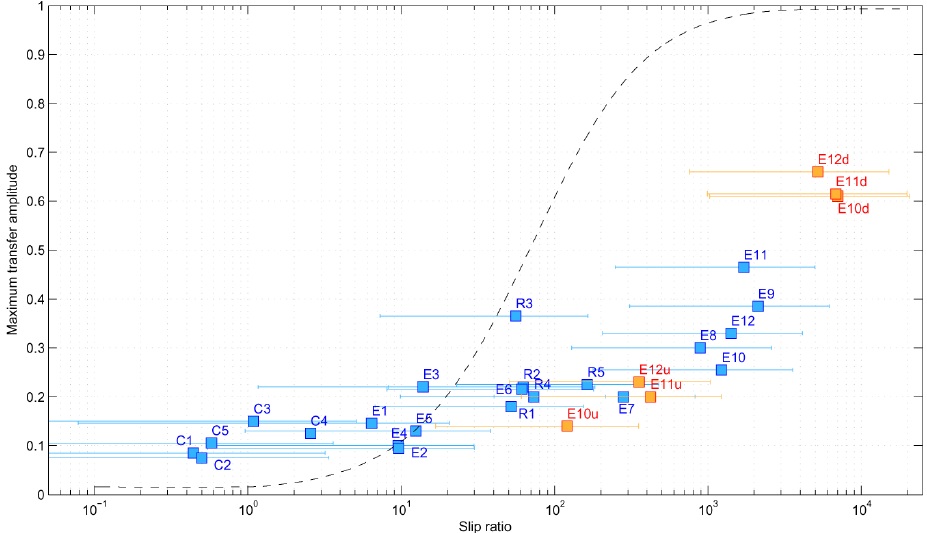
Fig. 5. Blue squares represent a scatter plot of the maximum transfer amplitude as a function of the mean slip ratio for all 22 profiles in this study. The plot shows a clear increasing trend for increasing values of the slip ratio. Error bars depict the maximum uncertainty in the slip ratio due to a lack of knowledge about the ice viscosity. Lower limits correspond to the assumption of a temperate ice column, whereas upper limits are obtained for a uniform ice temperature of − 20 ◦ C. The dashed line corresponds to the flow-line prediction of the full Stokes system for α = 0 . 003rad. Orange data points show the maximum transfer amplitude and mean slip ratio for the upper sections (denoted by an index u ) and lower sections (denoted by an index d ) along flight lines E10, E11 and E12.